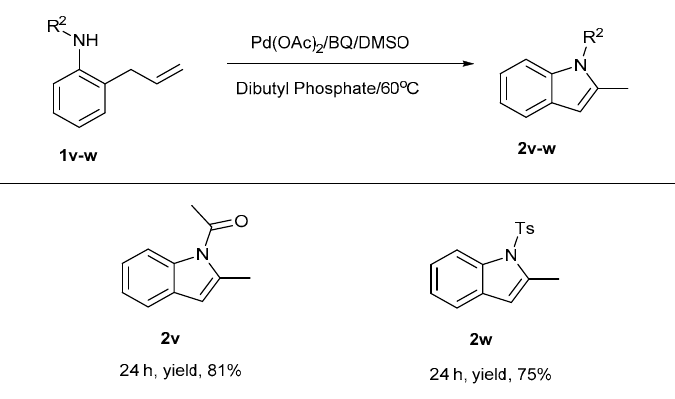
Table 4. Indoles with different N -substituents. a, b . Conditions: See Supplementary Materials for details.